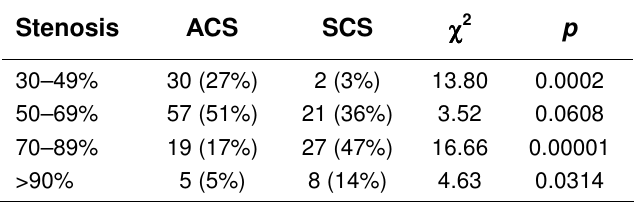
Number of Stenoses According to the Stenosis